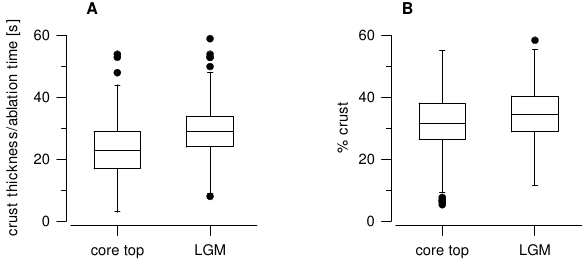
Fig. 8. Core top-LGM crust thickness (A) and crust proportion (B) changes in F-2 of N. dutertrei . Symbols as in Fig. 7.